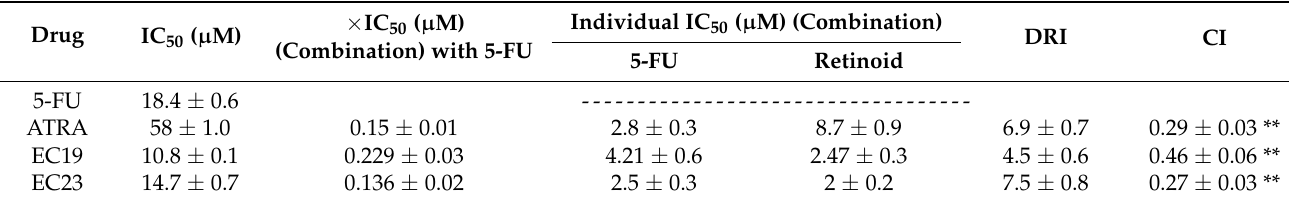
Table 2. Isobologram analysis of the combinations of individual retinoids and 5-fluorouracil (5-FU) (using fixed ratios of the individual IC 50 values) in Caco-2 cells. A synergistic effect was observed with the combination strategy. Dose reduction index (DRI) and combination index (CI) confirm the synergistic effect. Data represent mean ± SEM, n =